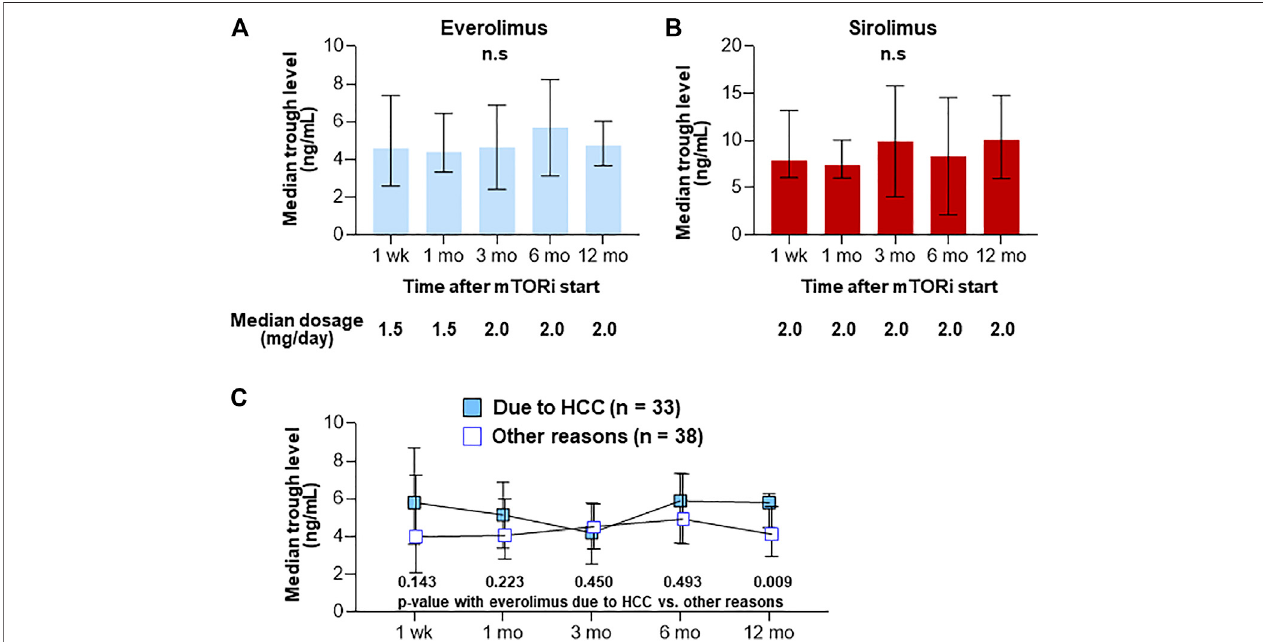
FIGURE 2 | Trough levels after the introduction of everolimus ( n (cid:1) 71) (A) and sirolimus ( n (cid:1) 13) (B) . Trough levels after the introduction in patients who received everolimus to prevent or to treat HCC recurrence ( n (cid:1) 33) tothe other group ( n (cid:1) 38) (C) . Graphs show median with IQR trough levels of each agent. n.s., not signi fi cant.